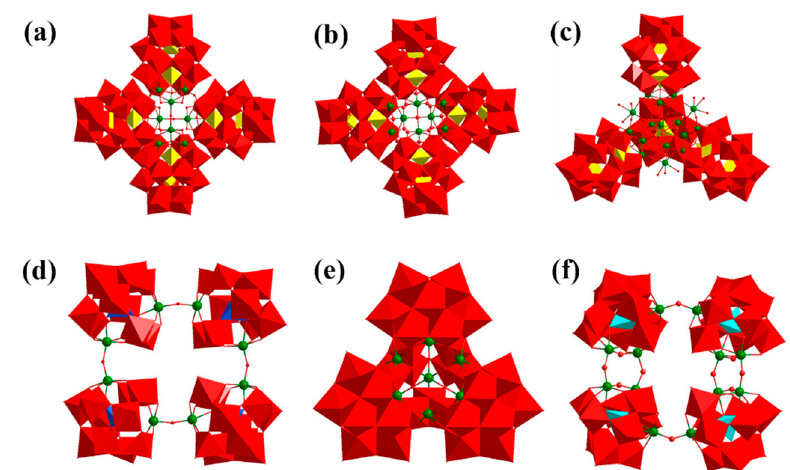
Figure 6. The ball-and-stick and polyhedral illustration of ( a ) [{Ti 3 P 2 W 15 O 57.5 (OH) 3 } 4 ] 24 − polyoxoanion, ( b ) [( α -1,2,3-P 2 W 15 Ti 3 O 60.5 ) 4 Cl] 37 − polyoxoanion, ( c ) [( α -1,2,3-P 2 W 15 Ti 3 O 62 ) 4 { µ 3 -Ti(OH) 3 } 4 Cl] 45 − polyoxoanion, ( d ) [{ β -Ti 2 SiW 10 O 39 } 4 ] 24 − polyoxoanion, ( e ) [Ti 6 (TiO 6 ) (AsW 9 O 33 ) 4 ] 20 − polyoxoanion and ( f ) [{K 2 Na(H 2 O) 3 }@{(Ti 2 O) 2 -(Ti 4 O 4 ) 2 (A- α -1,3,5-GeW 9 O 36 ) 2 (A- α - 2,3,4-GeW 9 O 36 ) 2 }] 25 − polyoxoanion. Color codes: WO 6 , red; PO 4 , yellow; SiO 4 , light blue; GeO 4 , turquoise; Ti, green; As, lavender; O, red.